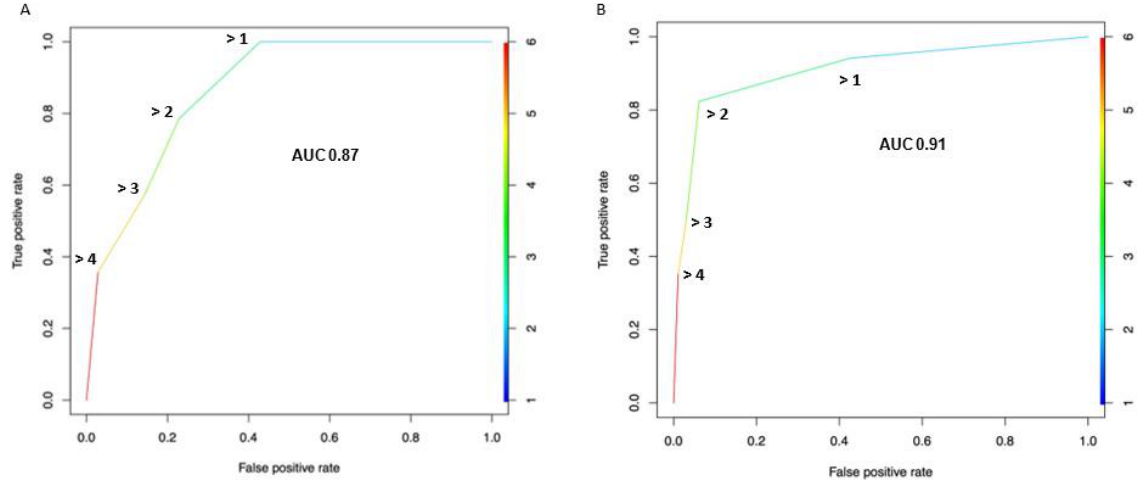
Figure 4. Receiver operating characteristic (ROC) curve depicting the diagnostic performance of the Node-Rads score for the detection of lymph-node invasion across all possible cut-offs, at both the patient ( A ) and lymph node levels ( B ). The area under the curve (AUC) was calculated and reported. True positive rate = sensitivity; false positive rate = 1 − specificity.